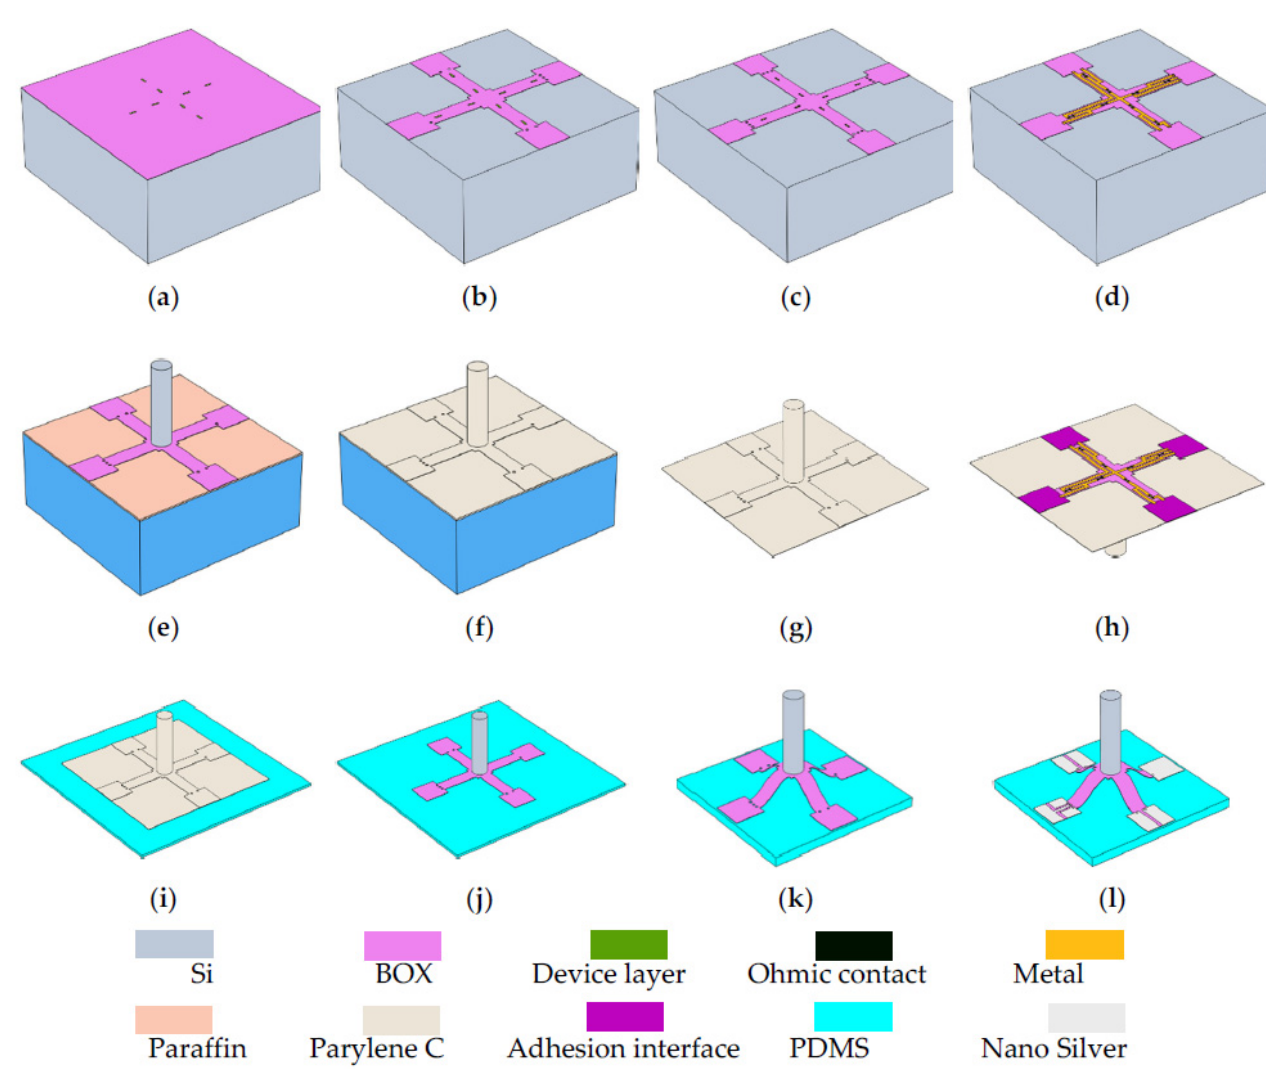
Figure 4. Sketch of the microfabrication process: ( a ) etch device layer; ( b ) etch BOX layer; ( c ) boron implantation; ( d ) sputter and graphical metal; ( e ) transfer to wafer and etch handle; ( f ) deposition Parylene C; ( g ) lift-off from water; ( h ) selective plasma treatment; ( i ) adsorption on the stretched PDMS; ( j ) remove Parylene C; ( k ) release PDMS and implement buckling; ( l ) electrical connections.